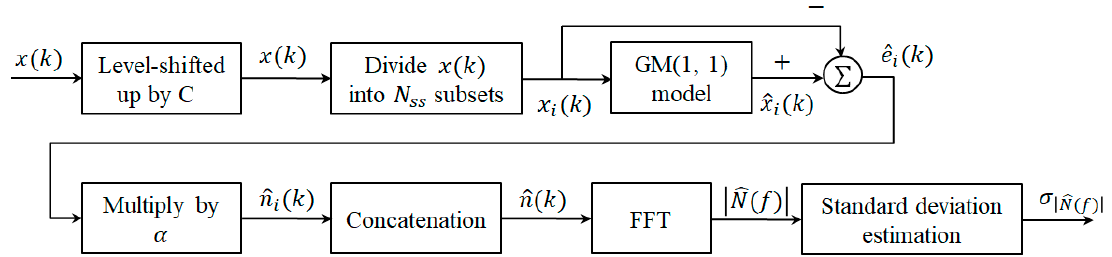
Figure 1. The block diagram of the the grey spectral noise estimation (GSNE).